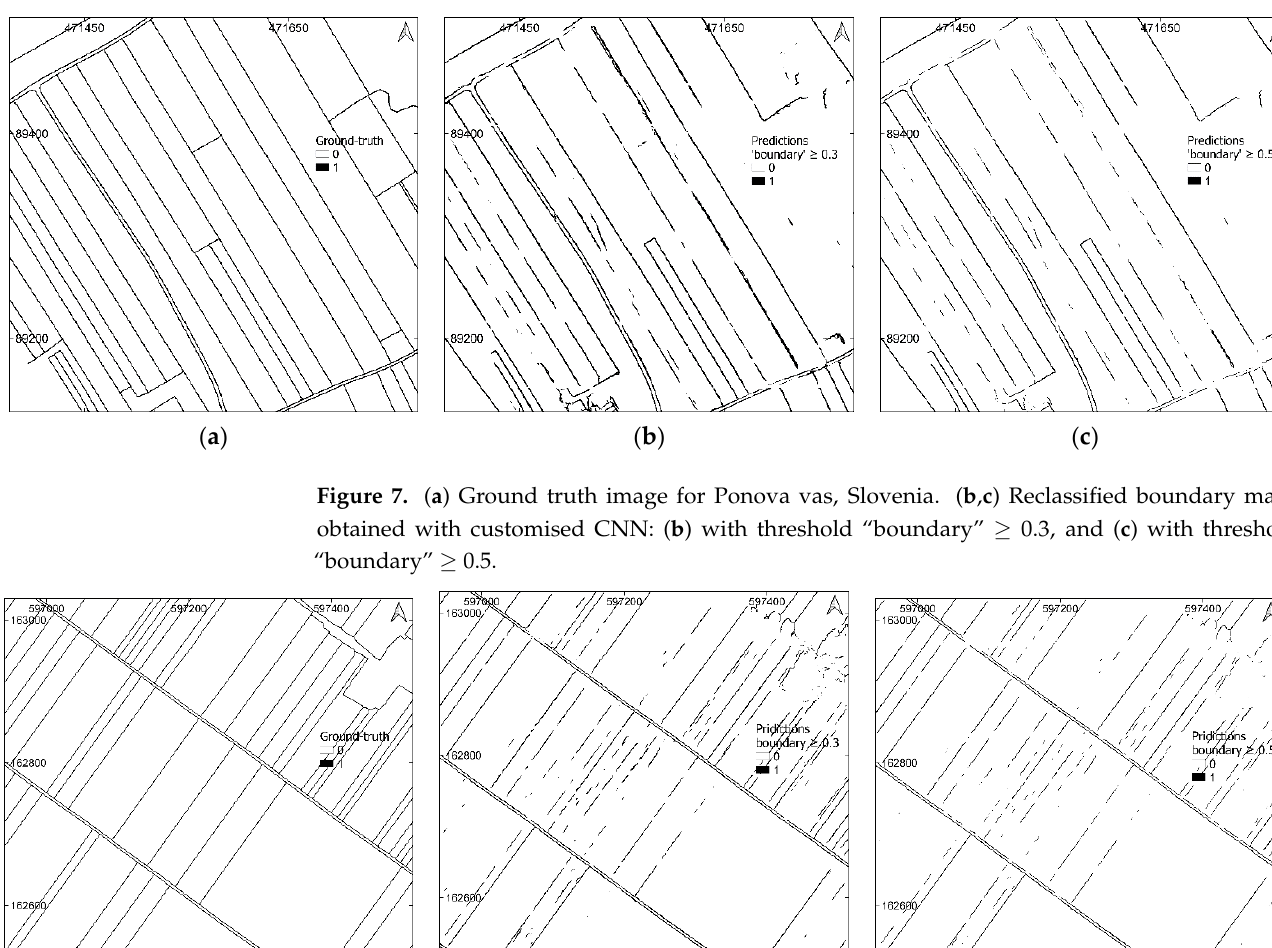
Figure 6. Georeferenced and merged boundary maps for the test area in ( a ) Odranci, Slovenia. Predicted boundary map with ( b ) customised CNN, and ( c ) original U-Net architecture.